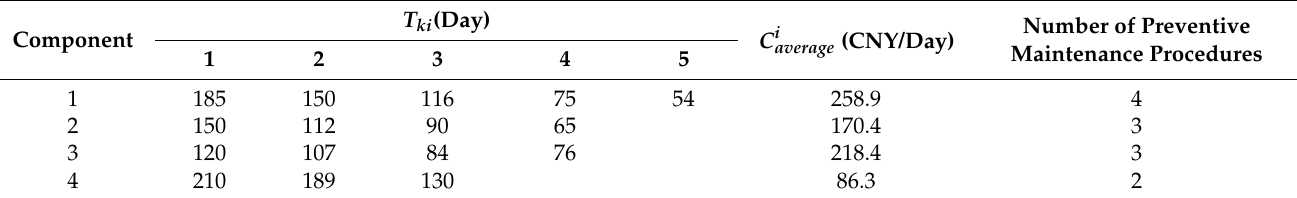
Table 4. Preventive maintenance interval of each component (calendar time).